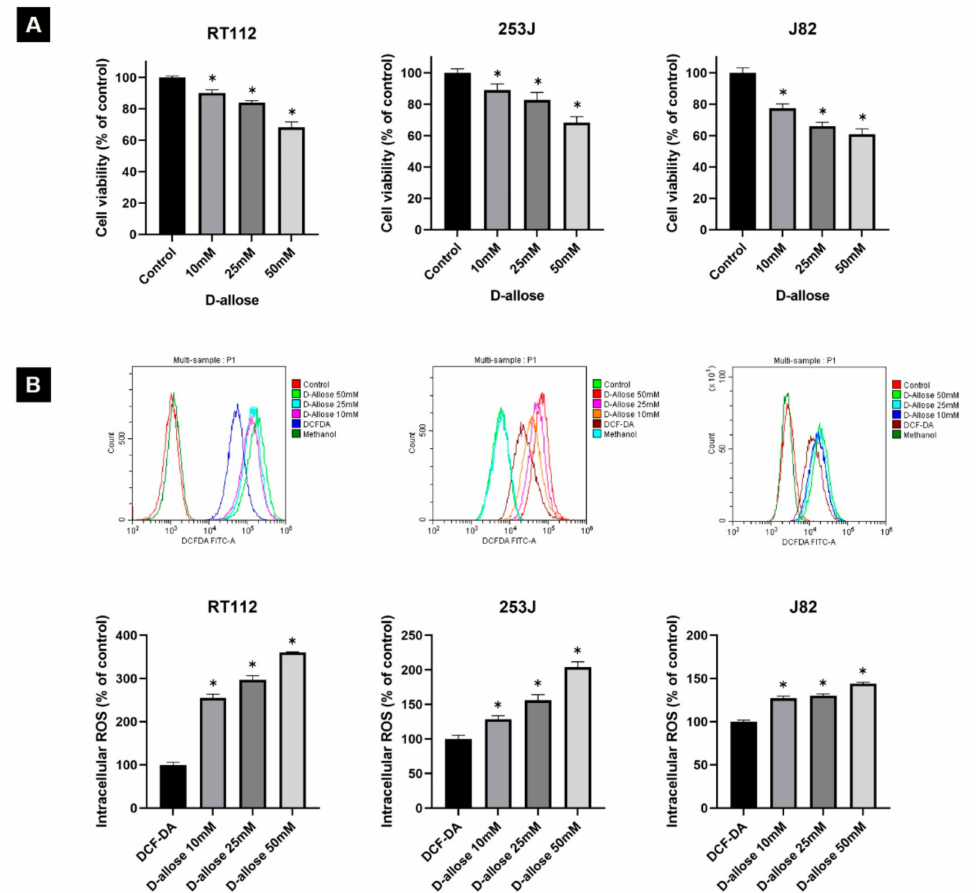
Figure 1. D-allose inhibits cell viability and induces intracellular reactive oxygen species (ROS) in three bladder cancer cell lines. ( A ) An MTT assay reveals that treatment with varying concentrations